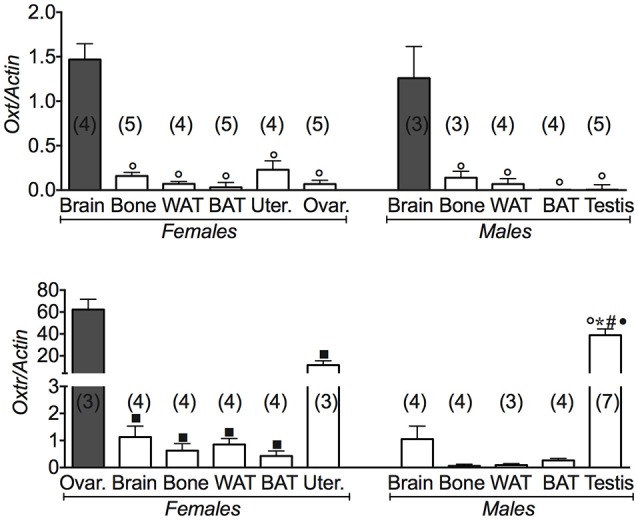
Oxytocin gene and its receptor in different tissues of 3 months old female and male mice. Relative expression levels of the oxytocin gene and its receptor in brain, bone, white adipose tissue (WAT) and brown adipose tissue (BAT), uterus, ovaries and testis of 3 months old female and male mice. Ovaries data were used as positive control for Oxt and Oxtr. The genes under investigations were: the oxytocin (Oxt) and oxytocin receptor (Oxtr) gene. In each graph, the bars are the means ± SEM from the n animals indicated in brackets. Differences were found within groups and between groups as determined by one way analysis of variance for Oxt, and Oxtr. Data significantly different (P < 0.05) vs. brain (◦), bone (*), WAT (#), BAT (•), and (■) ovaries using Bonferroni analysis.